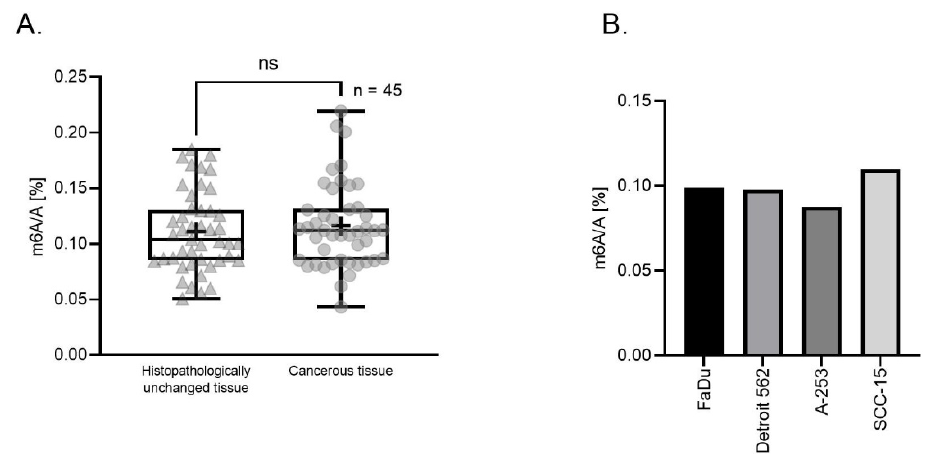
Figure 1. The percentage of m 6 A RNA modification in relation to adenosine (A) in total RNA derived from 45 head and neck squamous cancerous and paired-matched histopathologically unchanged tissues ( A ) and 4 cell lines (FaDu, Detroit 562, A-253, SCC-15) ( B ). ns (non-significant), + (mean value).